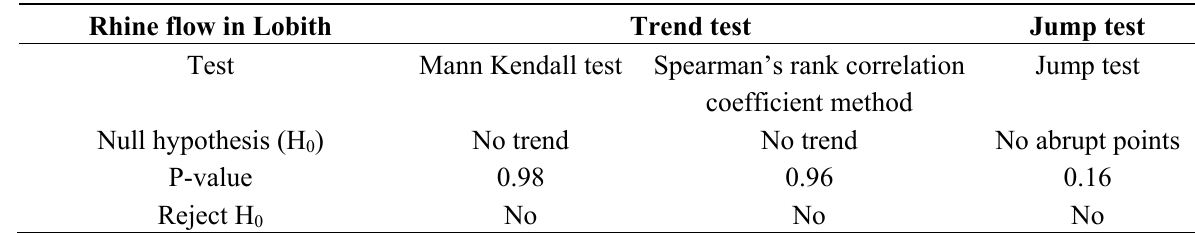
Table 4. Tests on Rhine flow at